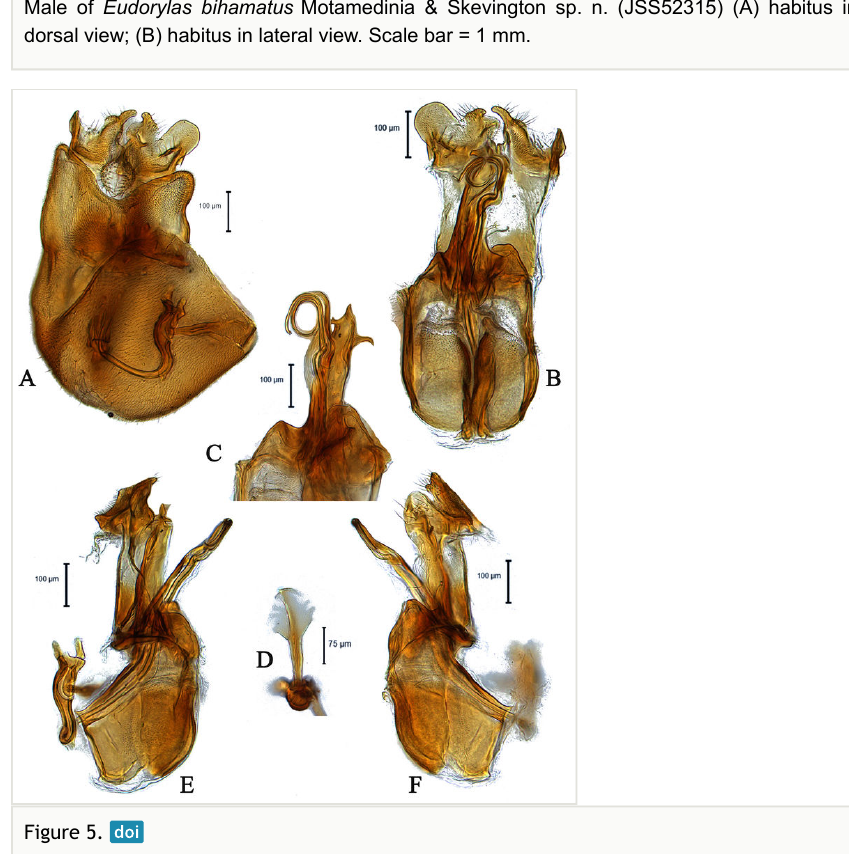
Figure 4. Male of Eudorylas bihamatus Motamedinia & Skevington sp. n. (JSS52315) (A) habitus in dorsal view; (B) habitus in lateral view. Scale bar = 1 mm.